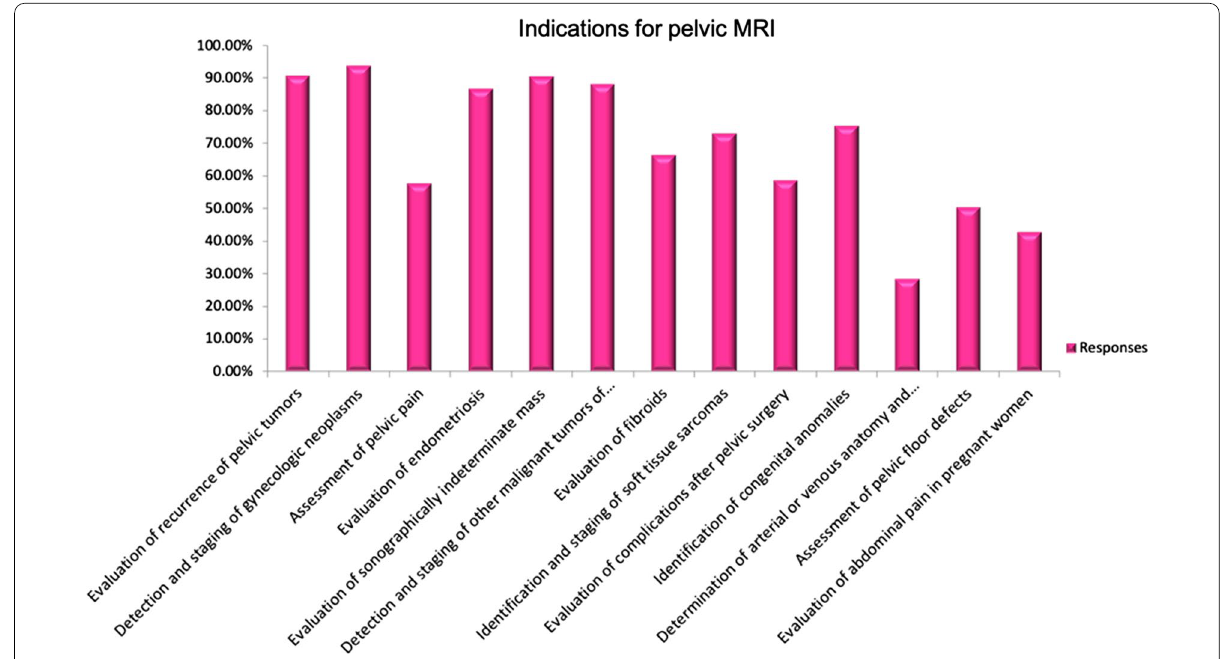
Fig. 2 Indications for pelvic